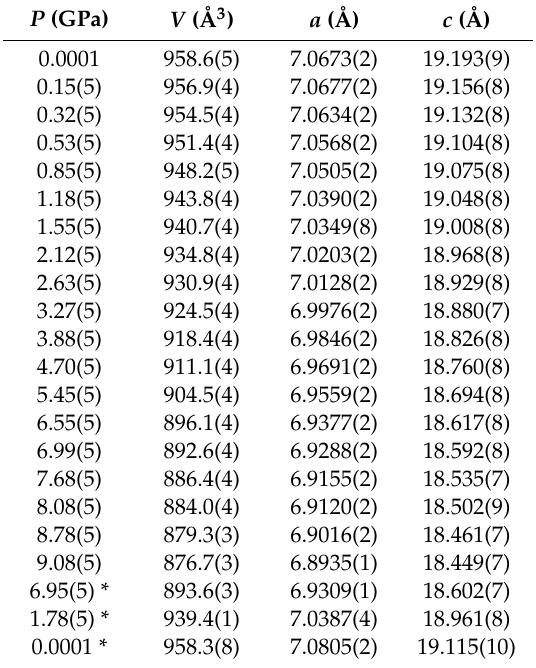
Table 1. Unit-cell parameters of wardite with pressure (* data collected in